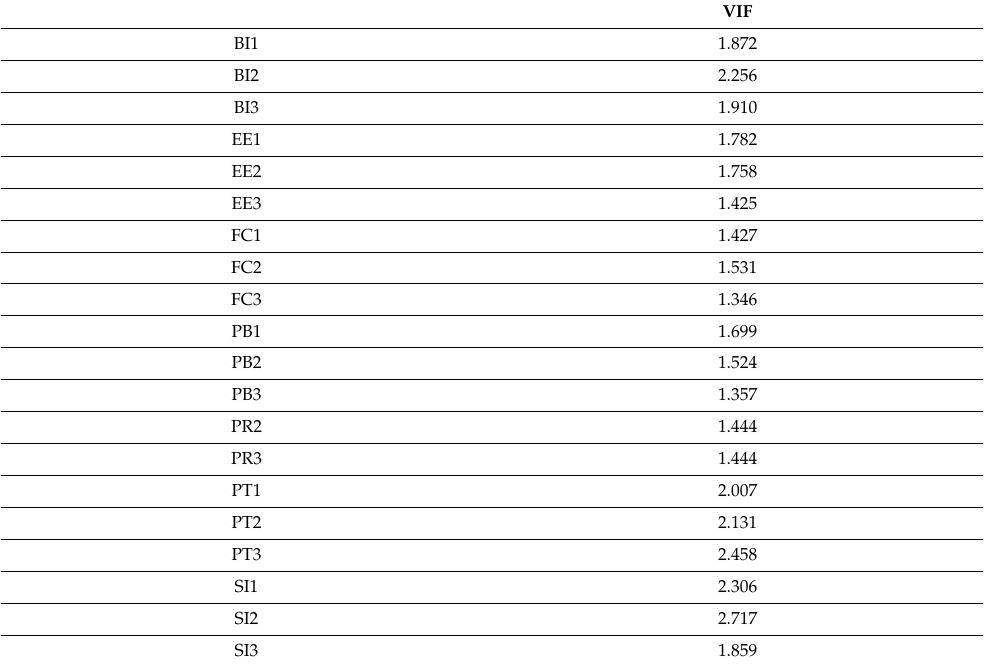
Table 6. Values of variance information